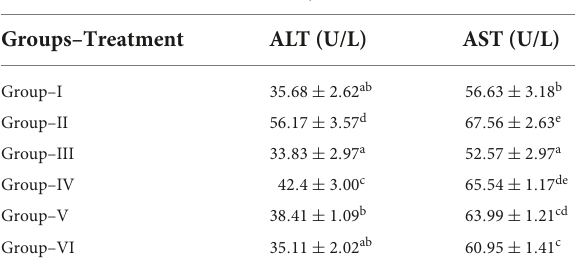
TABLE 5 Effect of ethanolic extract Solanum torvum fruits on liver enzymes in streptozotocin-induced diabetic Sprague–Dawley (SD)